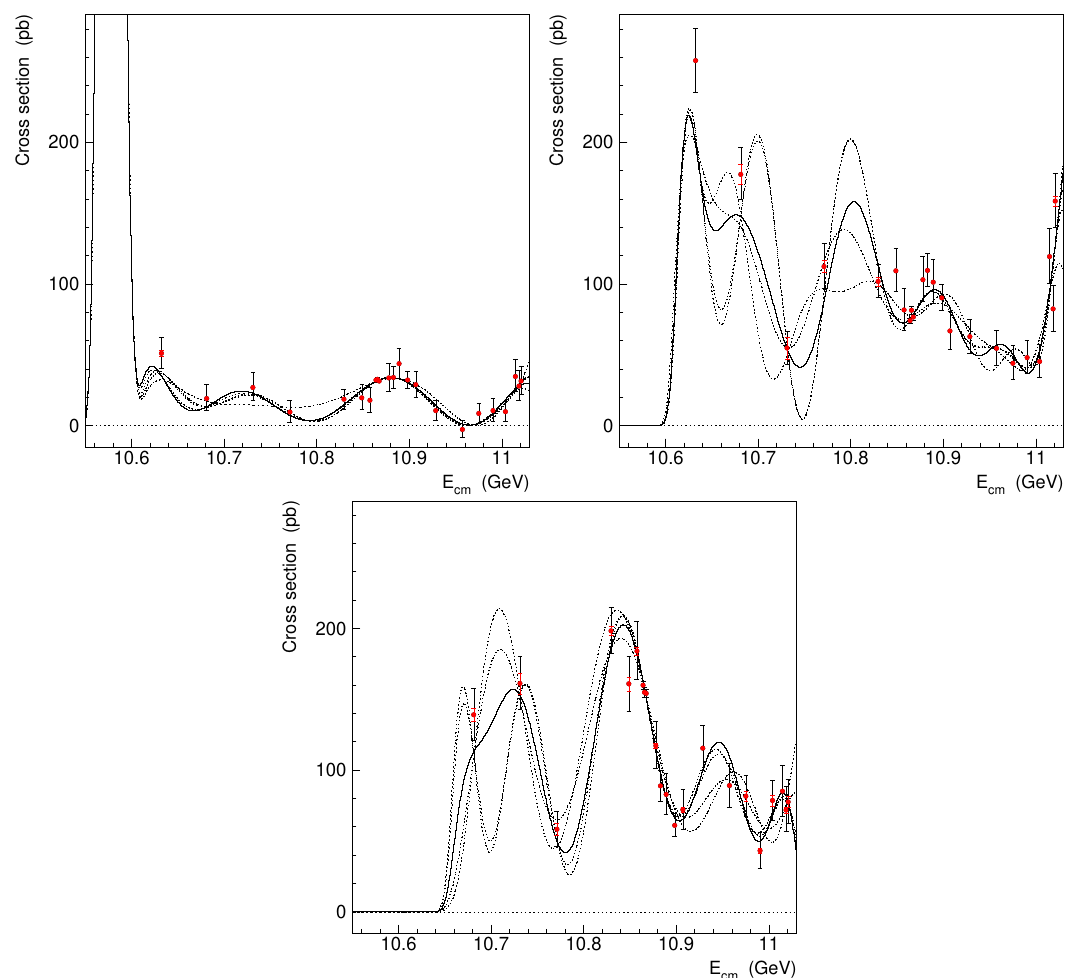
Figure 11 . Measured dressed cross sections at various energies for e + e − → B ¯ B (left), e + e − → B ¯ B ∗ (right), and e + e − → B ∗ ¯ B ∗ (bottom). The outer error bars indicate the statistical uncertainties and the inner red error bars indicate the systematic uncertainties due to the cross section parame- terization. Solid curves show the fit results for the default set of polynomial orders. Dotted curves show the fit results for the polynomial orders varied by ± 1 and ± 2